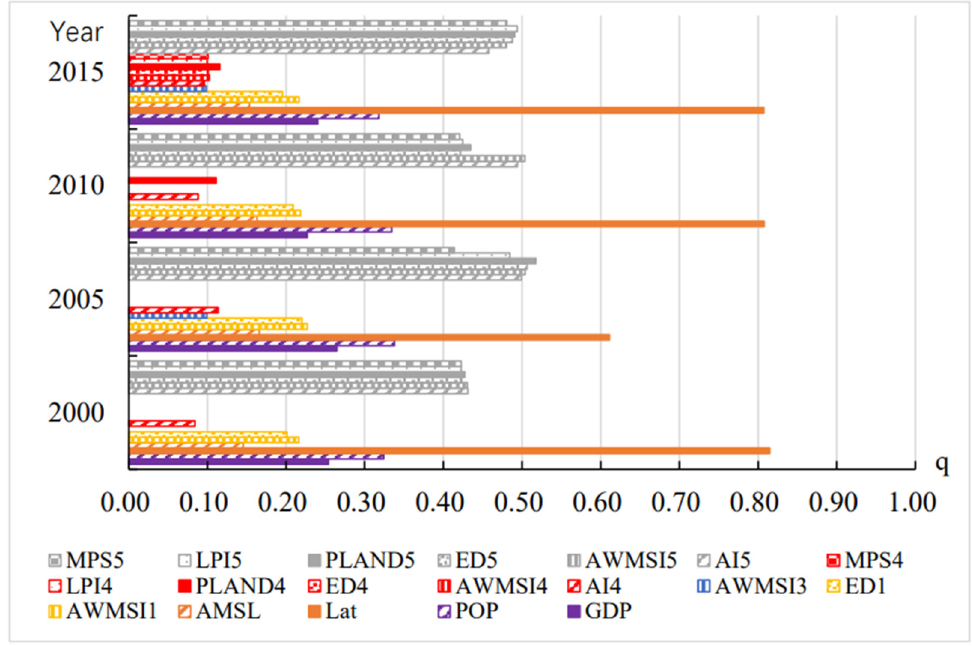
Figure 10. Q statistics between UTCI annual mean and driving factors (1: cultivated land; 2: green space; 3: water bodies; 4: construction land; 5: unused land).